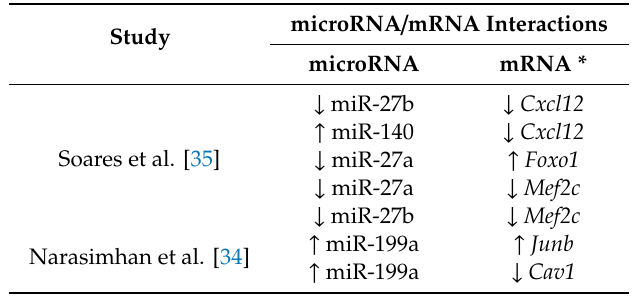
Table 3. Identification of new relevant microRNA–mRNA interaction in muscle wasting in cancer cachexia.